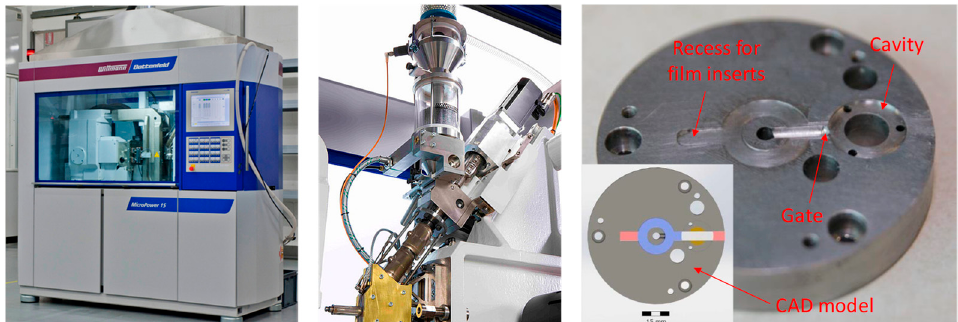
Figure 3. Wittmann–Battenfeld Micro Power 15 micro injection moulding machine used for the experiment ( left ), the injection unit of the of moulding machine ( middle ); and mould insert used in the tool to injection moulding of the FIM part ( right ).